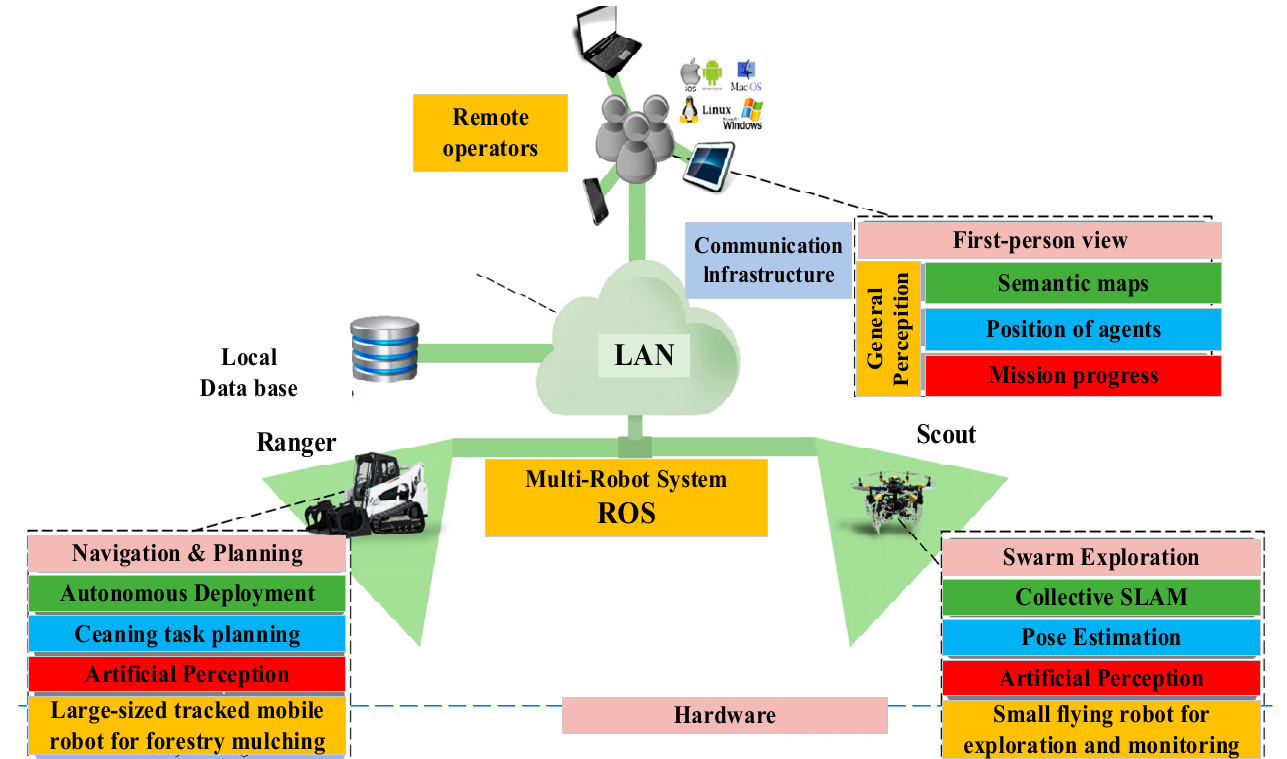
Figure 4. Diagram overview of forestry multi-robot strategy (Figure from [87]).